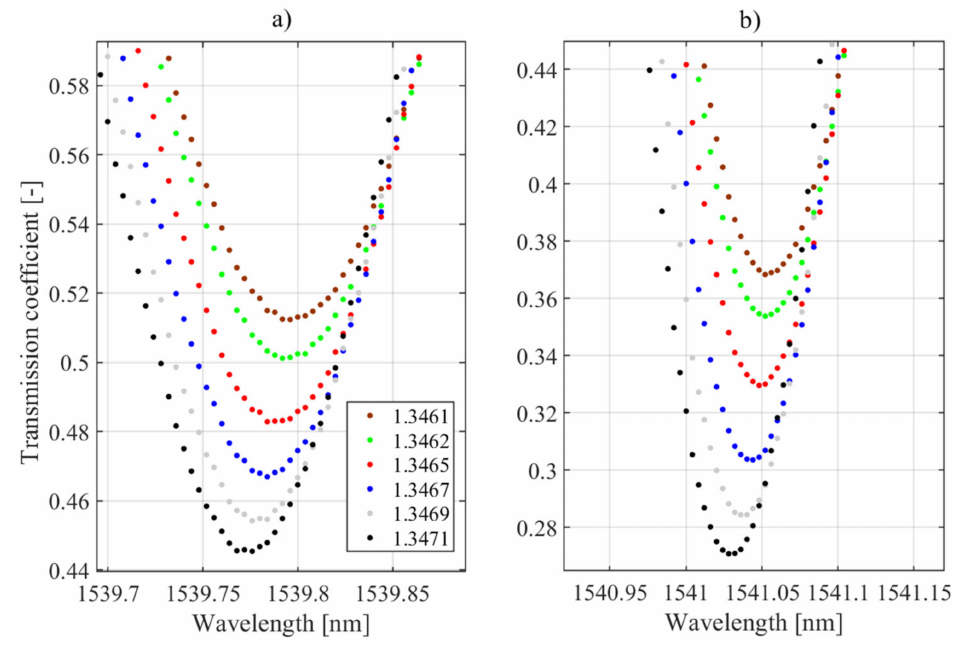
Figure 20. Results of the spectral measurements for TTFBG modal preselection. ( a ) mode @1539.8 nm, ( b ) mode @1541.05